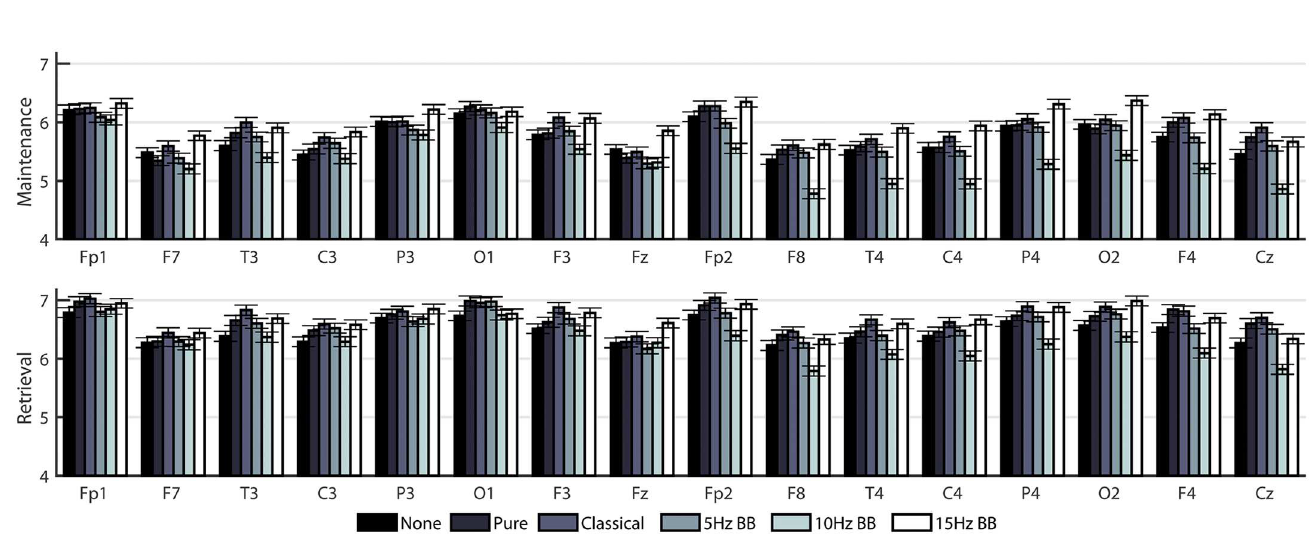
Fig 6. Mean degree of EEG nodes in cortical networks for all six acoustic stimulation conditions. Bars indicatestandard